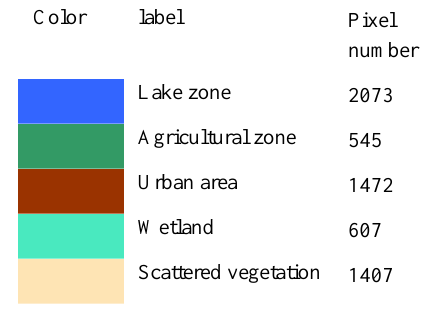
Table 1. Minimum Distance samples number